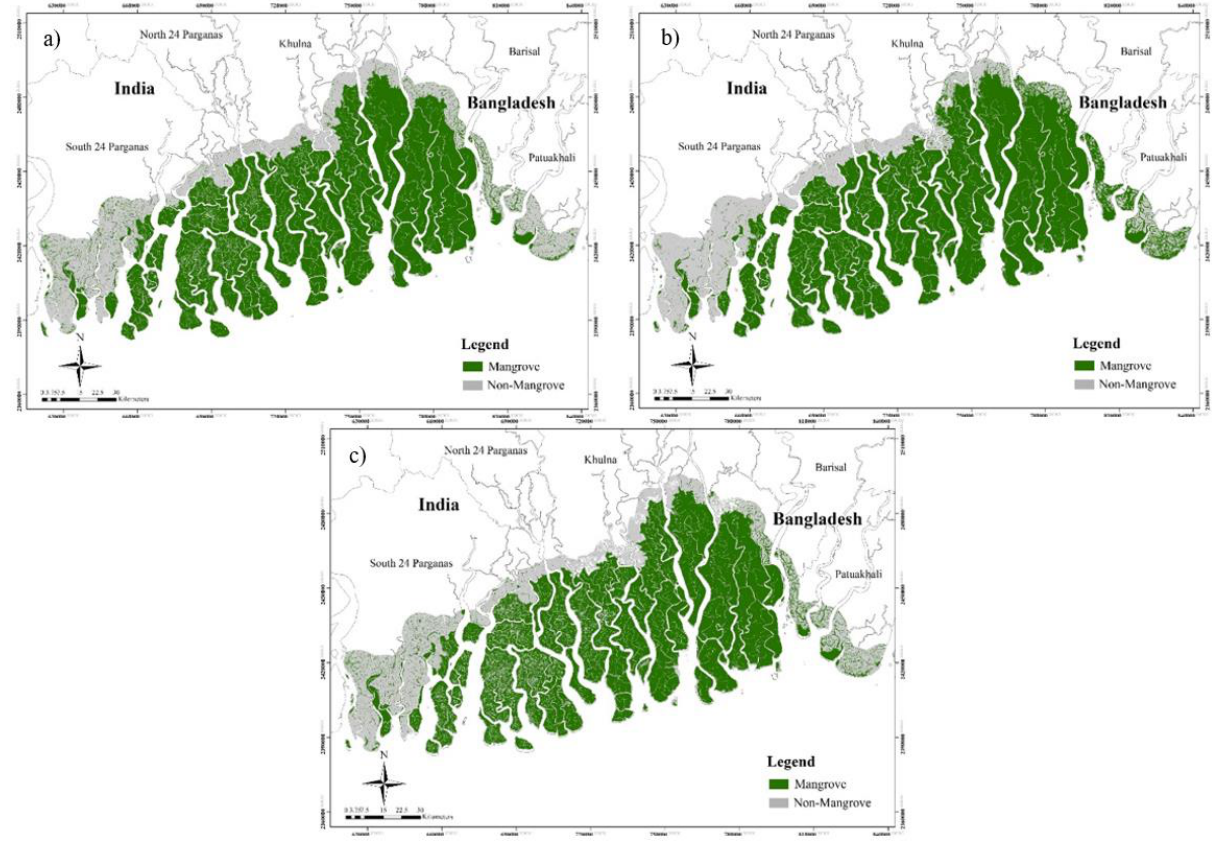
Figure 8. Spatial distriution of mangrove forest in a) 1988, b) 2001, and c) 2014 in the Sundarbans delta derived from Landsat imagery.